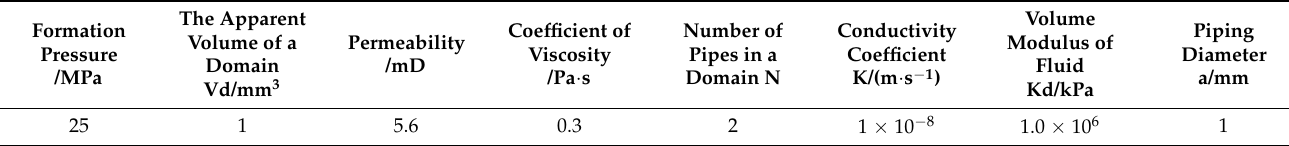
Table 2 below: Table 2. The basic parameters of the fluid